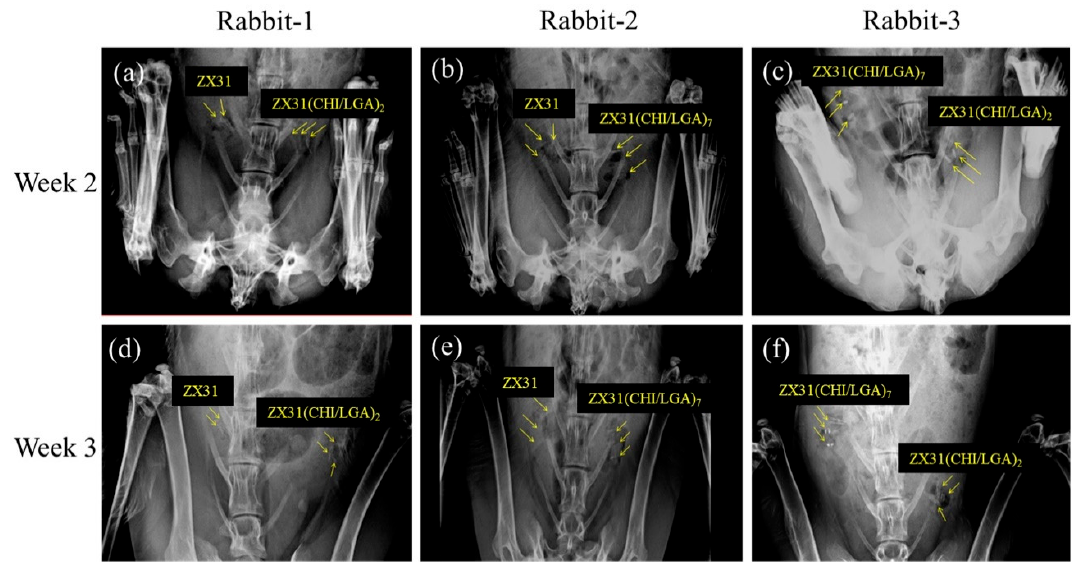
Figure 8. X-ray images of rabbits with Mg clips taken two and three weeks after surgery: ( a ) ZX31 and ZX31(CHI / LGA) 2 Mg clips on the left and right uterine tubes of rabbit-1, respectively (second week); ( b ) ZX31 and ZX31(CHI / LGA) 7 Mg clips on the left and right uterine tubes of rabbit-2, respectively (second week); ( c ) ZX31(CHI / LGA) 7 and ZX31(CHI / LGA) 2 Mg clips on the left and right uterine tubes of rabbit-3, respectively (second week); ( d – f ) the clips in the third week.